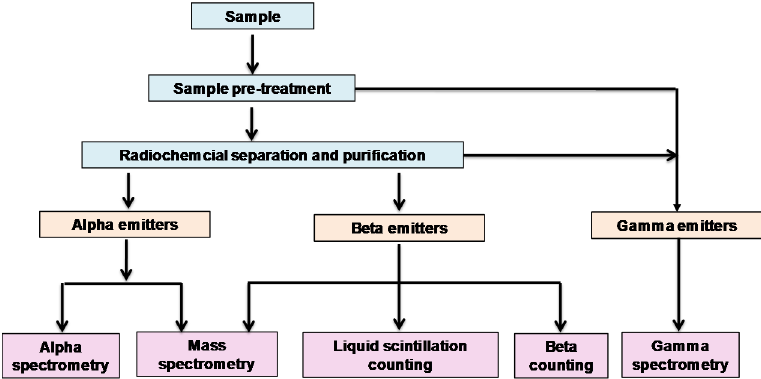
Figure 2. Schematic illustration of the overall procedure for radionuclide determination.